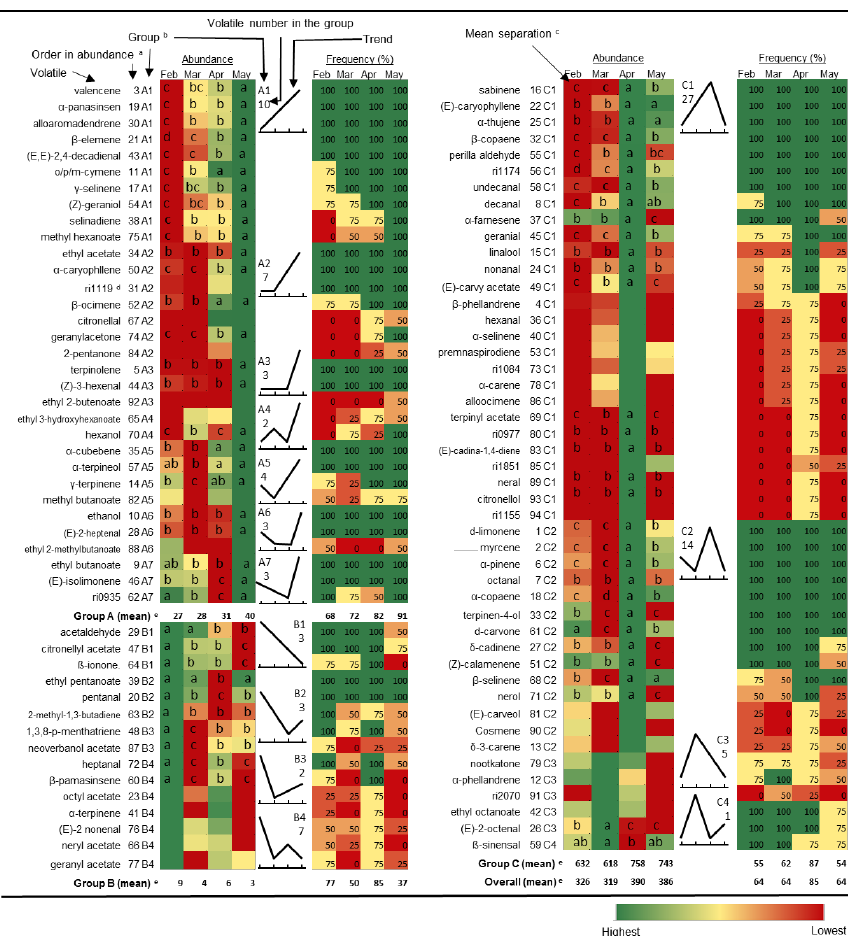
Figure 1. Changes in volatile abundance and frequency of detection in “Valencia” orange juice samples harvested from February to May 2012 ( n = 4). a order in abundance listed by average peak size (total ion current) from high to low in total of 94 peaks; b groups: A-increase; B-decrease; C-peak with sub-groups in numbers; c the same letter within the same row (compound) represents no significant different at 0.05 level; d unknown compound with the retention indices (ri + a 4 digital number); e Average abundance (x 10 7 total ion current) and frequency of detection (%).